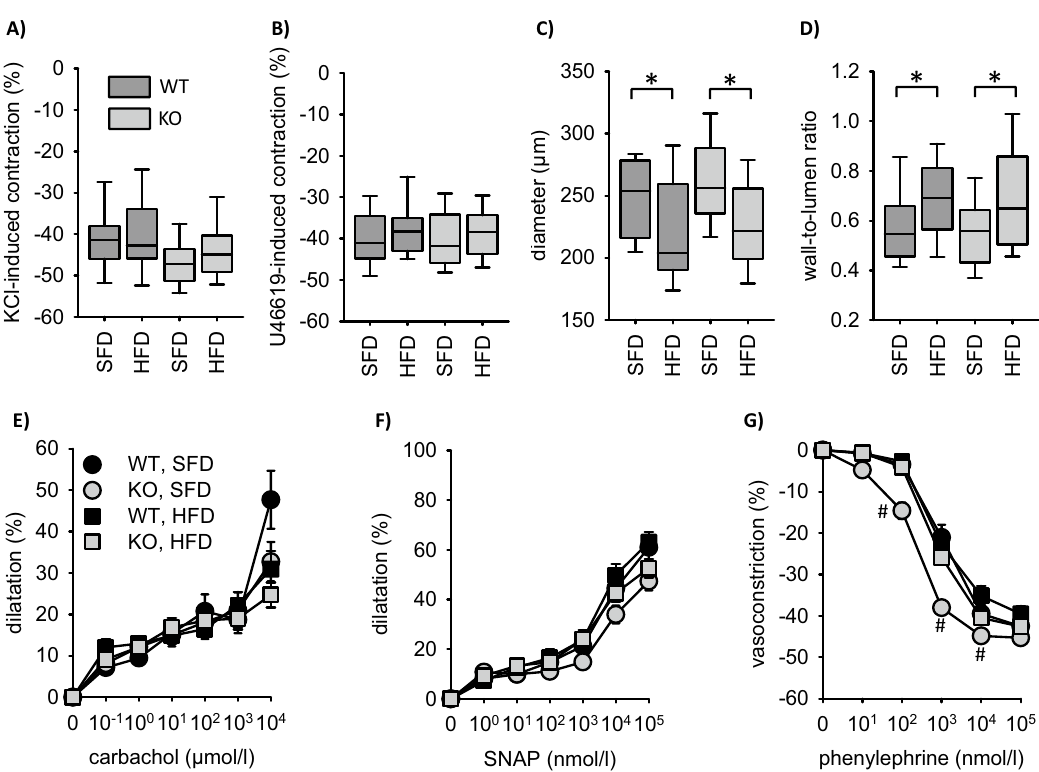
Figure 5. Pressure myography in mesenteric arteries of the EC-EGFR model. ( A ) Contraction in reponse to 20 mmol/l KCl. ( B ) Contraction in response to 100 nmol/l U46619. ( C ) Diameter of mesenteric arteries. ( D ) Wall-to-lumen ratio of mesenteric arteries. ( E ) Carbachol-induced dilatation. ( F ) SNAP-induced dilatation. ( G ) Phenylephrine-induced contraction. Number of animals N(WT, SFD) = 8, N(WT, HFD) = 10, N(KO, SFD) = 10, N(KO, HFD) = 14. *p < 0.05. SFD standard diet, HFD high fat diet, WT wildtype, KO knockout. *p < 0.05. # p < 0.05 versus WT, SFD.